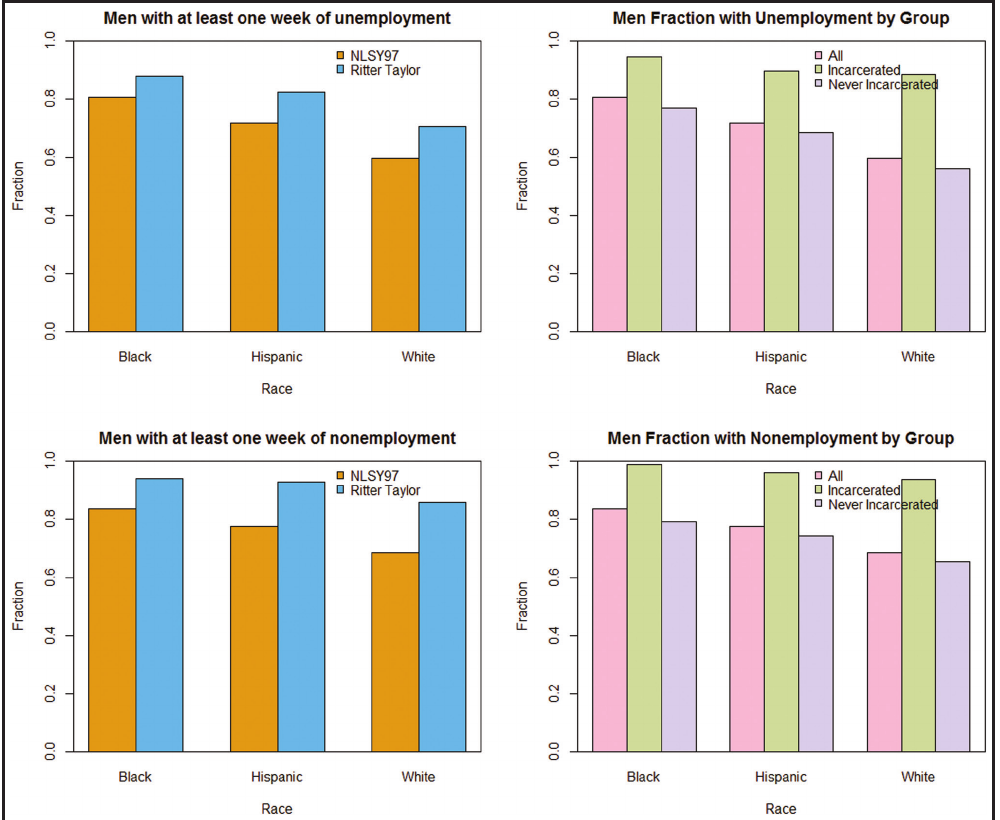
Unemployment and nonemployment by